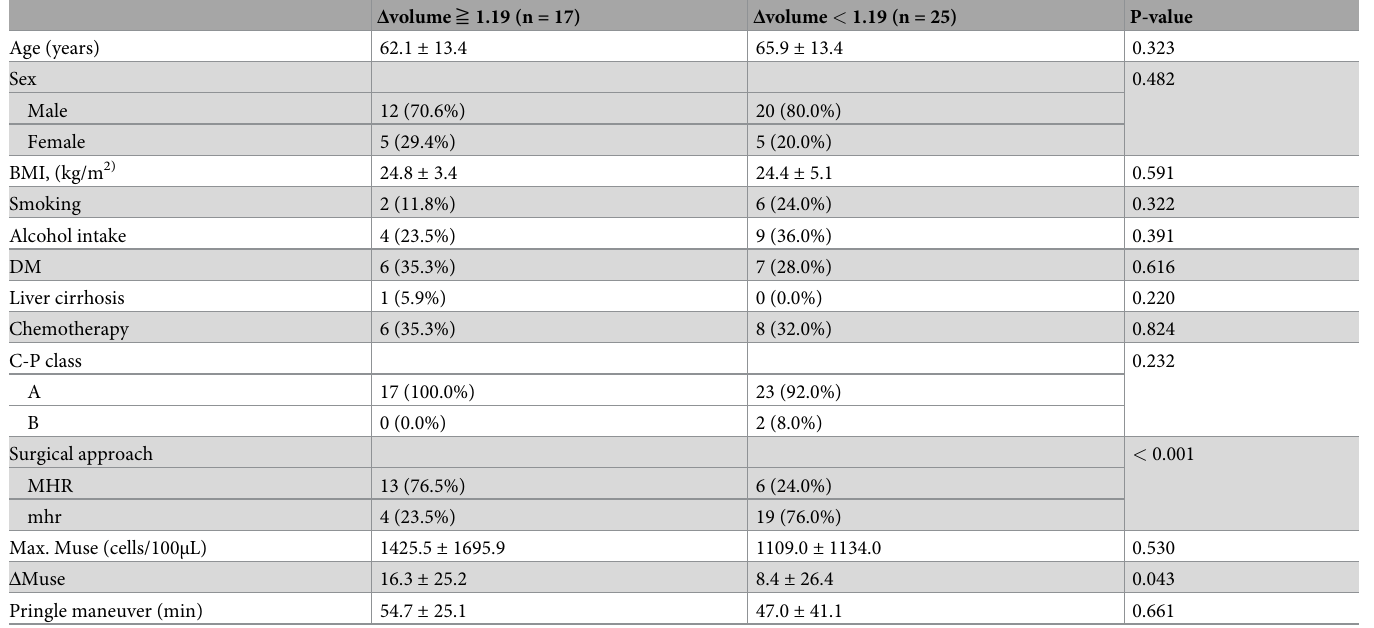
Table 3. Comparison of the factors affecting Δ volume in no complication